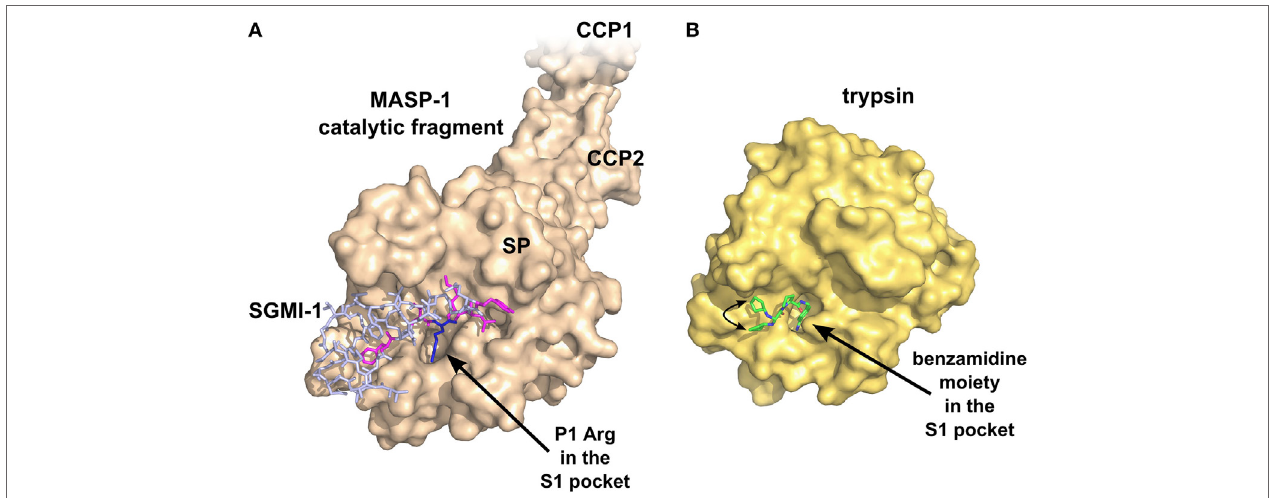
FiGURe 4 | Specific inhibition of proteases requires multiple favorable contacts in a large contact area with an inhibitor. (A) The structure of MASP-1 in complex with a specific small-protein inhibitor, SGMI-1 (PDB entry 4DJZ). SGMI-1 was developed by phage-display (122). Amino acid residues in the randomized positions are colored magenta (P4, P2, P1 ′ , P2 ′ , P4 ′ ) and blue (P1). All amino acid residues in the randomized positions have contacts with the protease body; moreover, SGMI-1 has other contact areas with MASP-1 in the non-randomized positions as well. (B) The structure of trypsin in complex with a non-specific small-molecule inhibitor (123) (PDB entry 3LJJ). The inhibitor is based on benzamidine. A two-headed arrow indicates the movement of the terminal cyclopentane moiety, which has two equivalent binding